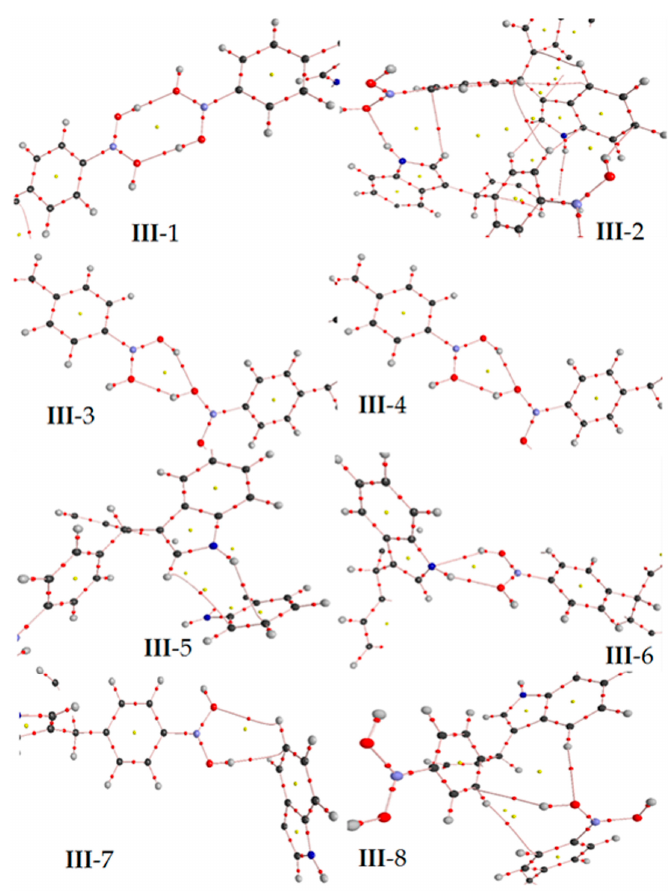
Figure 6. In the target molecule ( ct - III ) the bond critical points (3, − 1) is marked in red small points and ring critical points (3,+1) are presented as yellow points. The gray, blue, pink, red and white spheres are for carbon, nitrogen, boron, oxygen and hydrogen atoms respectively.